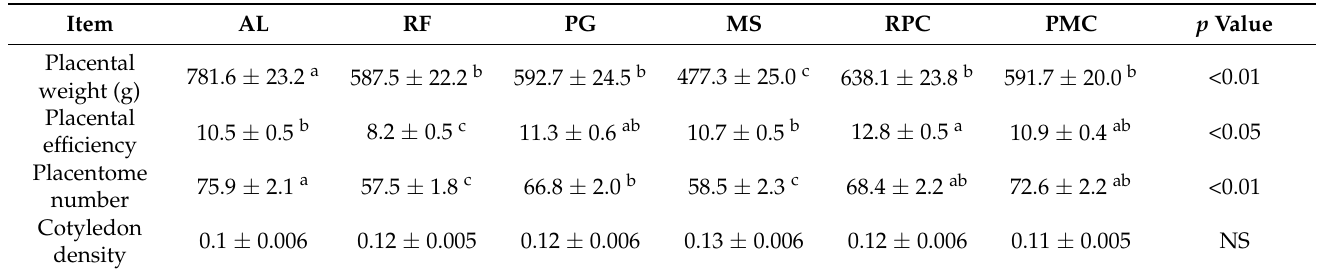
Table 2. Effect of feed restriction and supplementation with the 3 compounds propylene glycol, mon- ensin sodium, and rumen-protected choline chloride in late pregnancy on placental characteristics.